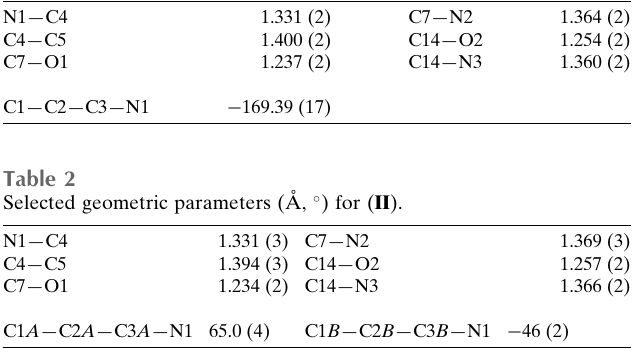
Figure 1 Diagram of polymorph ( I ) showing the atom-labelling scheme. Atomic displacement parameters are at the 50% probability level.